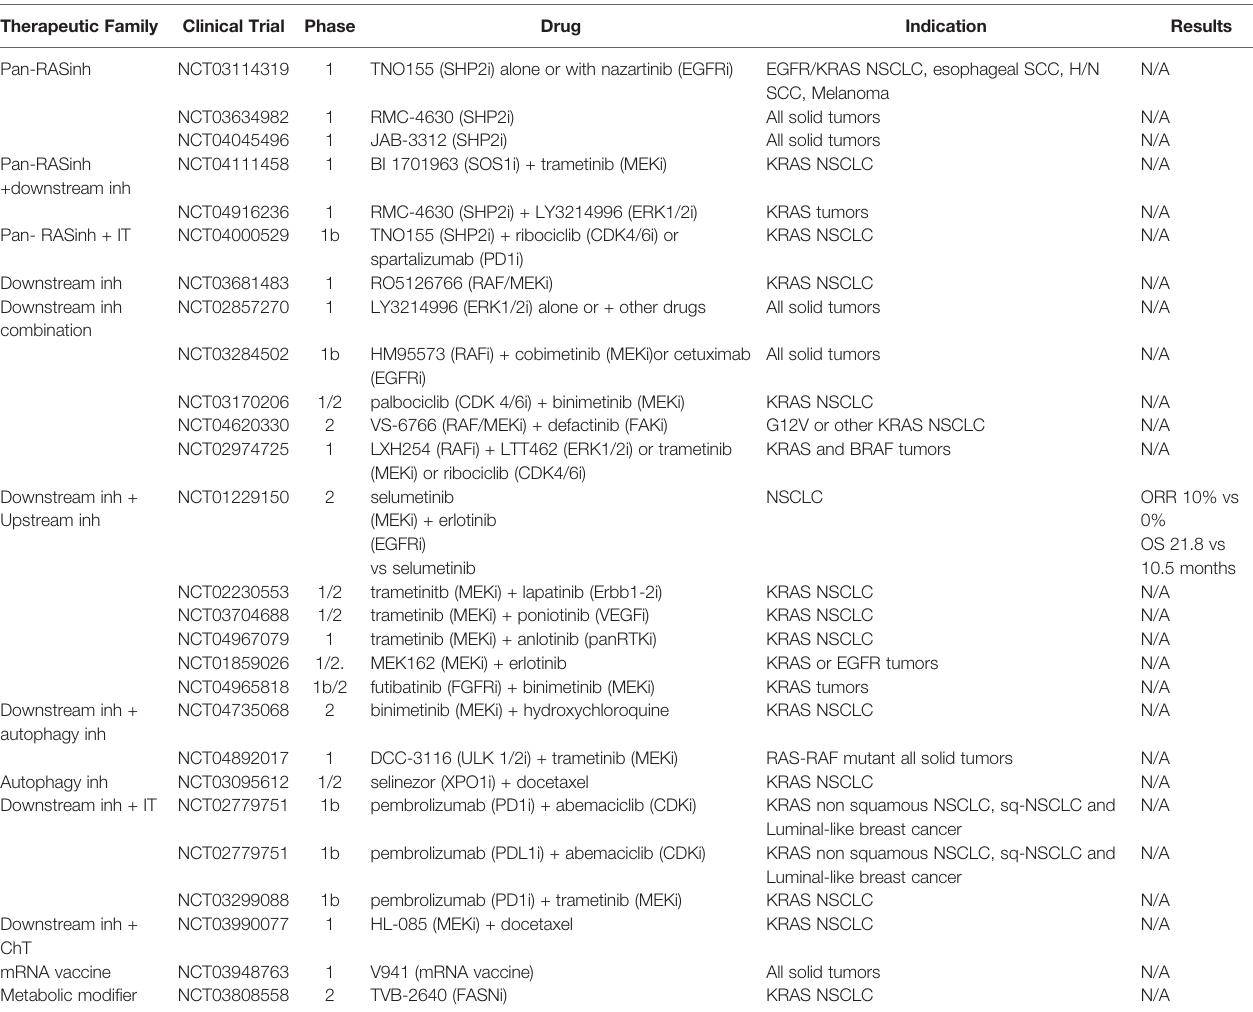
TABLE 1 | Clinical trials of drugs targeting